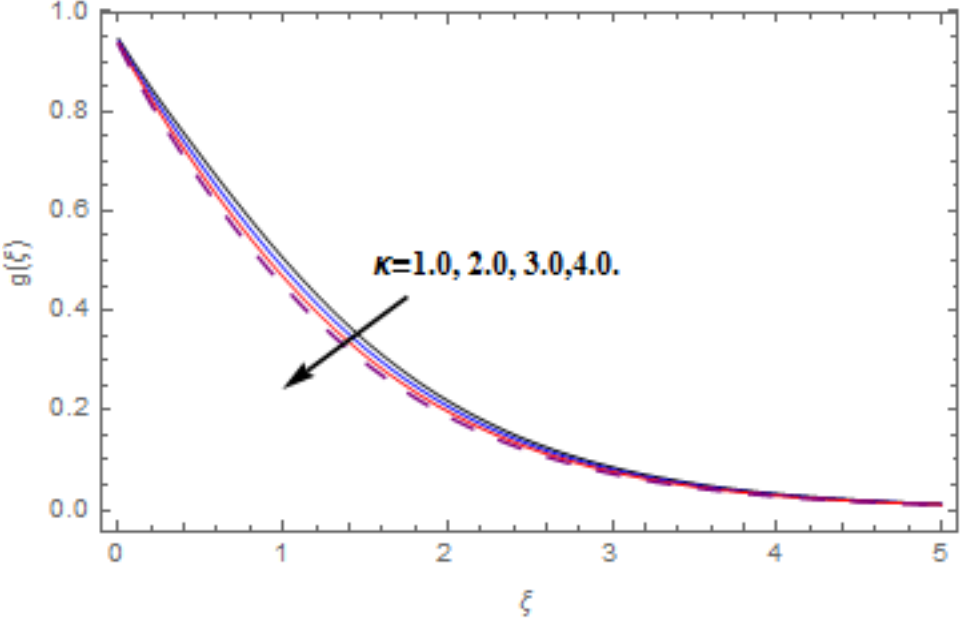
Figure 7. Varation in g ( ξ ) against κ , when M = ψ = 0.2, Nt = Nb = 0.5, Le = 1.0, Ec = 1.0, Pr = 1.2, Figure 7. γ = 0.1. Molecules 2020 , 25 , x FOR PEER REVIEW